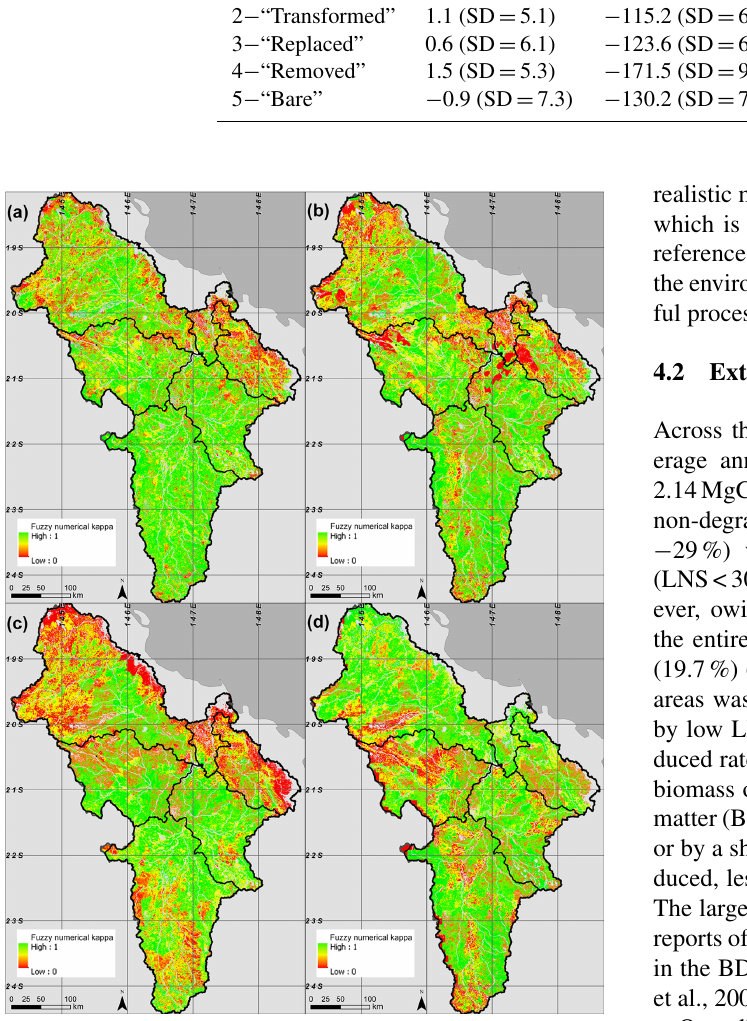
Figure 7. Similarities between (a) annual hillslope erosion, (b) gully density, (c) rainfall erosivity, and (d) sediment load and percentage LNS as indicated by fuzzy numeric